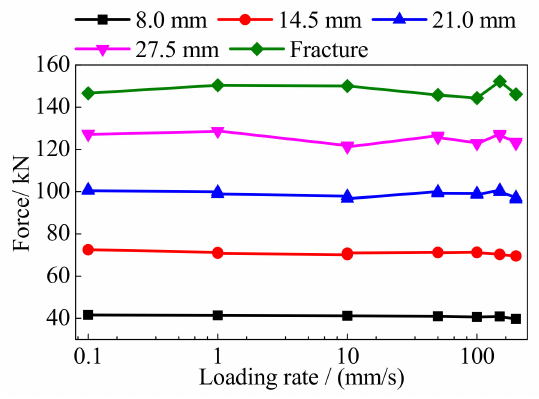
Figure 10. Peak force of the BFRP